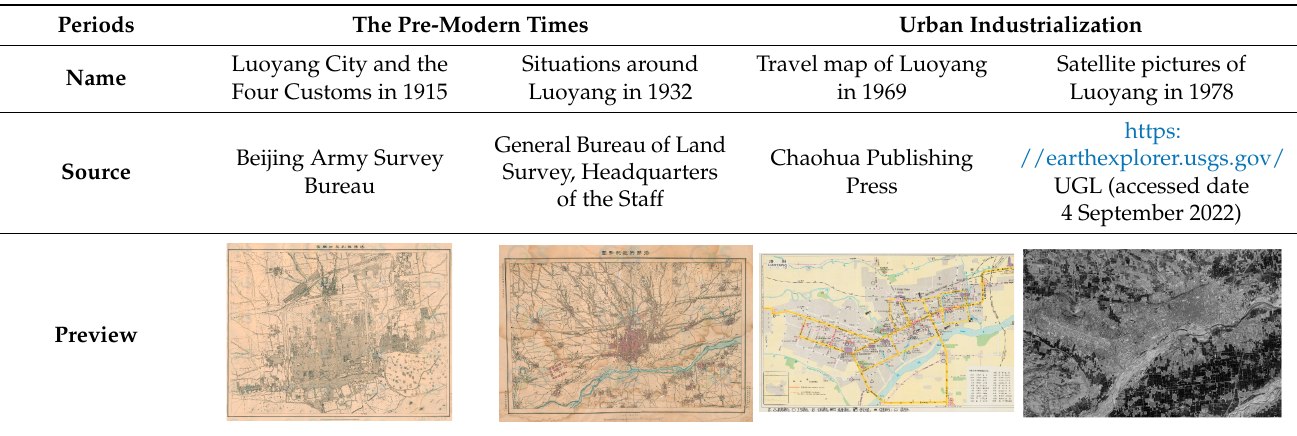
Table 1. Historical maps and satellite image of Luoyang.